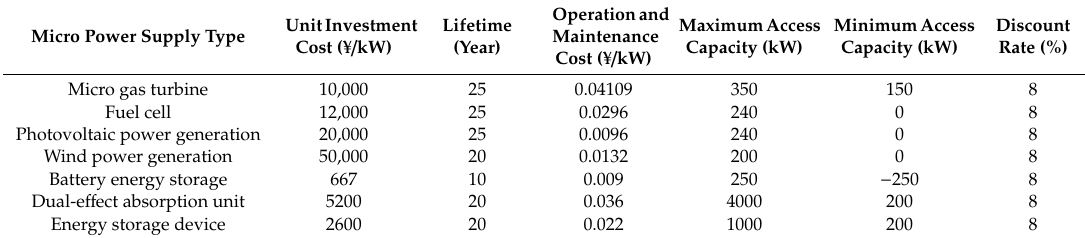
Table 2. Performance parameters of